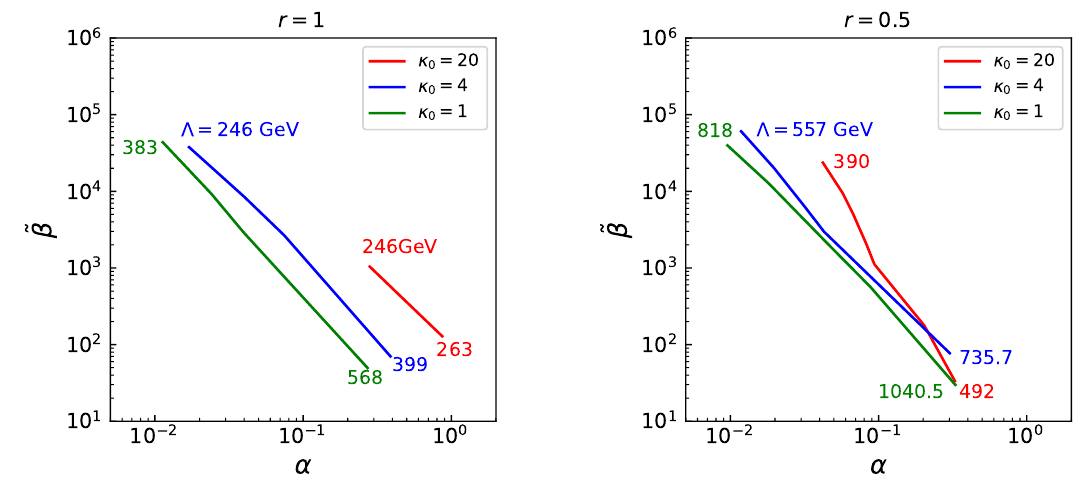
Figure 4 . α and ˜ β in our EFT. We fix r = 1 and 0 . 5 in the left and right figures, respectively. The green, blue and red lines correspond to κ 0 = 1 , 4 , and 20 cases. The numbers in these figures are the value of Λ